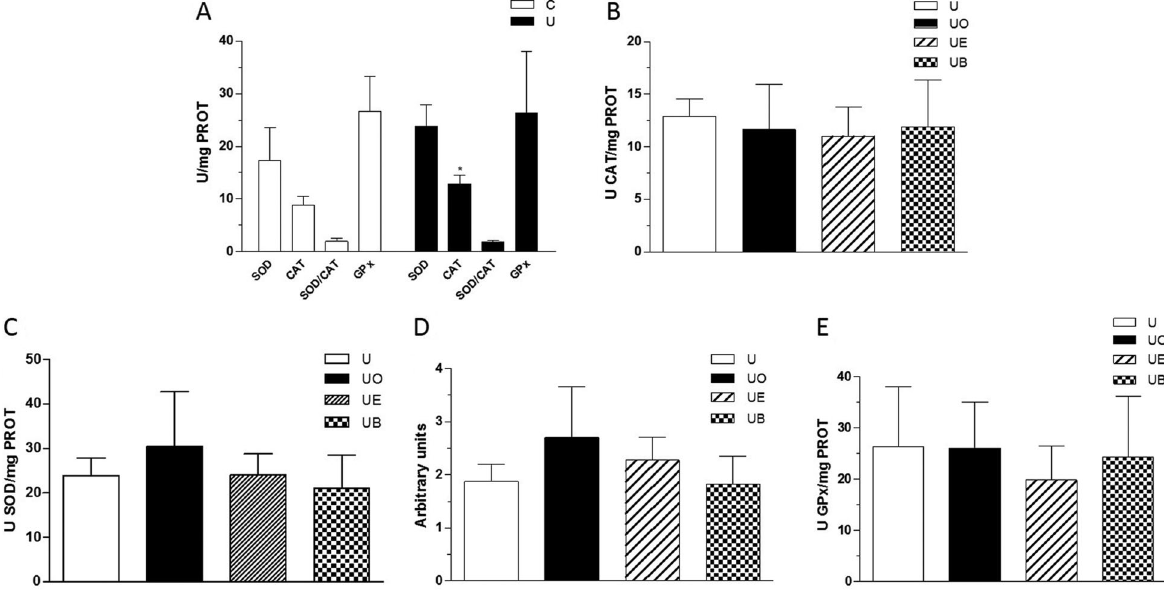
Figure 2. Quanti fi cation of activity of antioxidant enzymes in lung tissue specimens. A , Urethane-injected mice (U) had higher catalase (CAT) (*P=0.003) and superoxide dismutase (SOD) (P=0.07) activities compared to controls (C). B - E , There were no signi fi cant differences between the activities of CAT ( B ), SOD ( C ), SOD/CAT ratio ( D ), and glutathione peroxidase (CPx) ( E ). UO: urethane + pequi oil; UE: urethane + pequi ethanolic extract; UB: urethane + beta-carotene. ANOVA was used for statistical analysis.